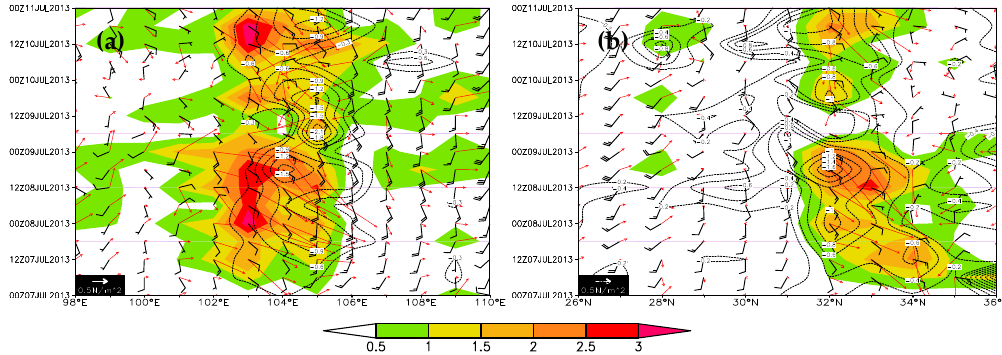
Figure 9. Temporal evolution of the surface gravity wave stress (red arrow and filled area, N/m 2 ), 700-hPa vertical velocity (dotted lines, Pa/s) and wind field (black, m/s) along 32° N ( a ) and 104° E ( b ) based on NCEP_FNL data.